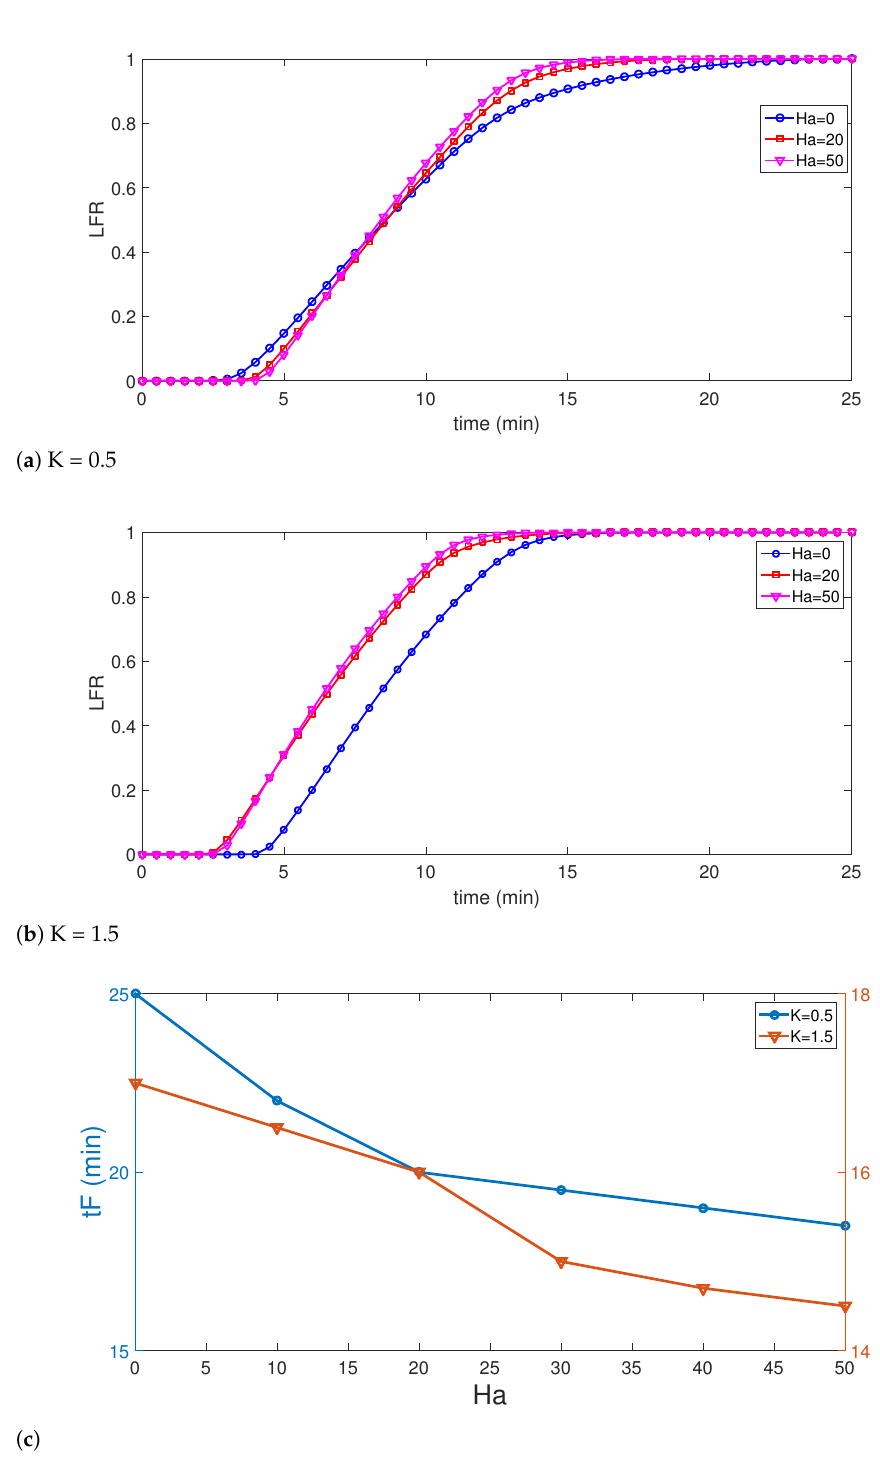
Figure 9. Impacts of MF strength on the dynamic features of the LFR at K = 0.5 ( a ), K = 1.5 ( b ) and on the complete phase transition time ( c ). In case ( c ), left and right y-axes show results for K = 0.5 and K = 1.5 (constant MF, M = 0.5, φ =